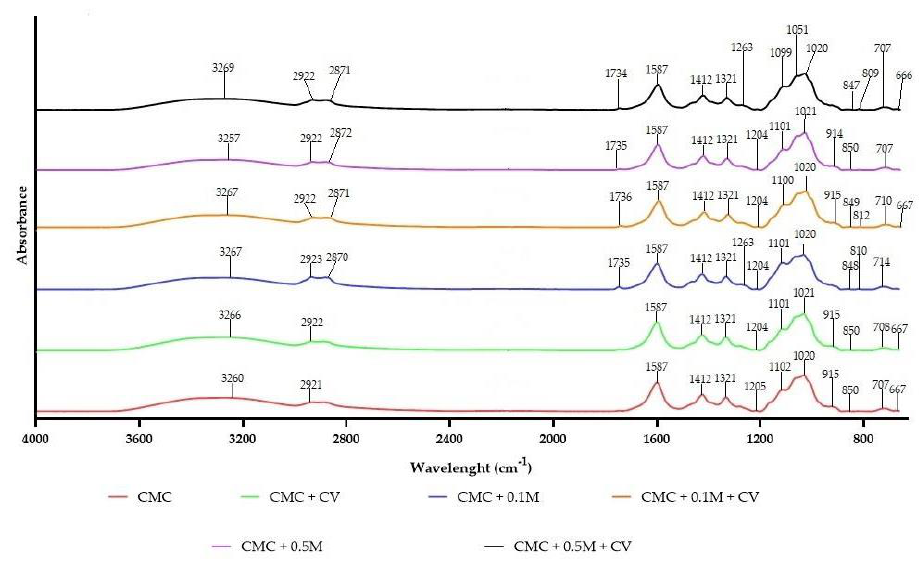
Figure 6. Fourier-transform infrared (FT-IR) spectra of CMC-based neat and modified films.